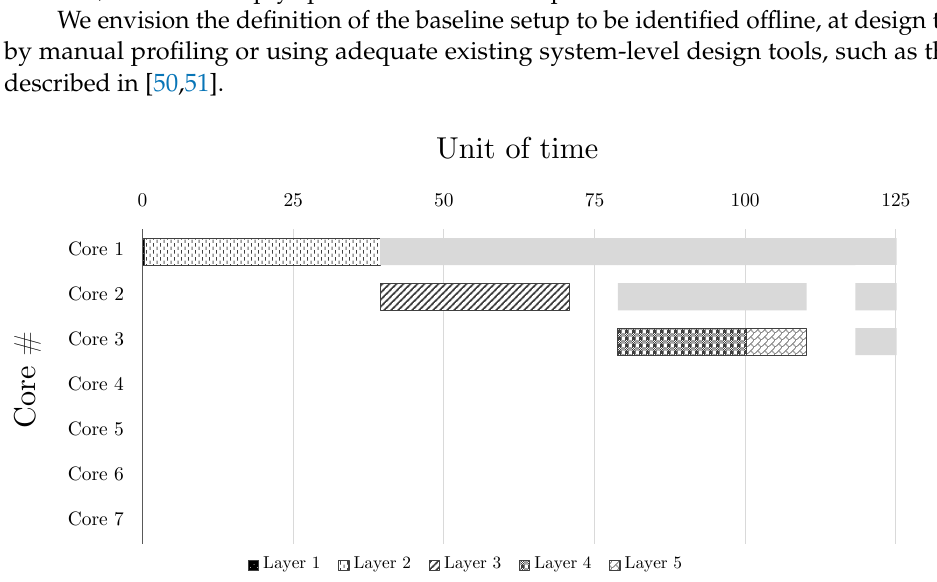
Figure 9. Example of balanced pipeline (gray shadows show the potential execution of successive pipelined computations of the same